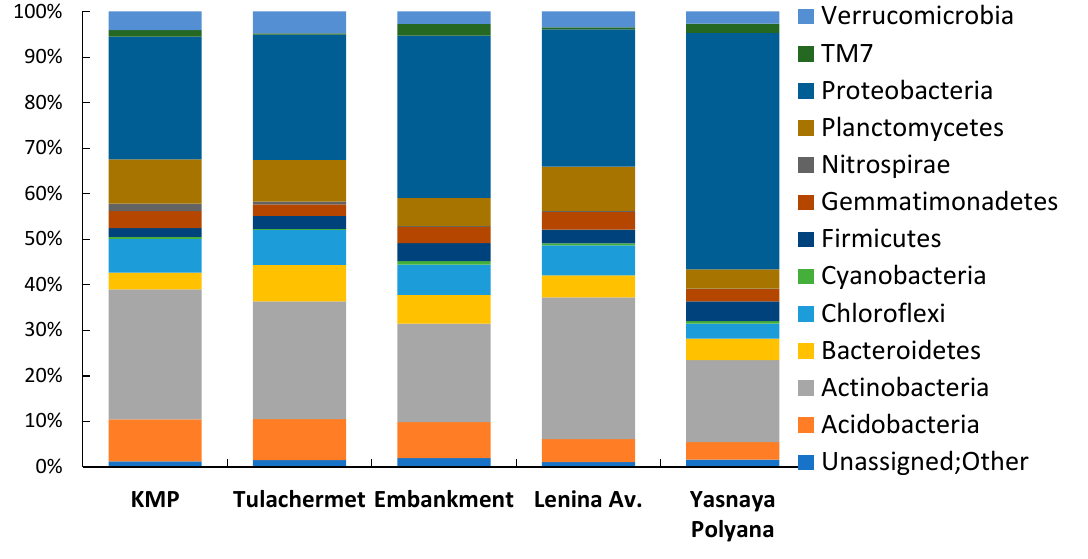
Figure A2. The relative abundances at the phylum level of the microbial communities in the rhizo- sphere of E. frumentacea grown on different soils. Table A1. Taxonomic structure of rhizosphere microbial communities of E. frumentacea (%). Taxonomic Associations of OTUs